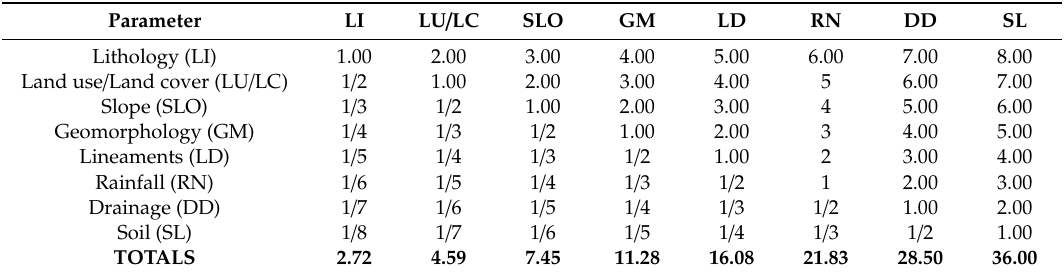
Table 3. Pair-wise comparison matrix for all parameters.